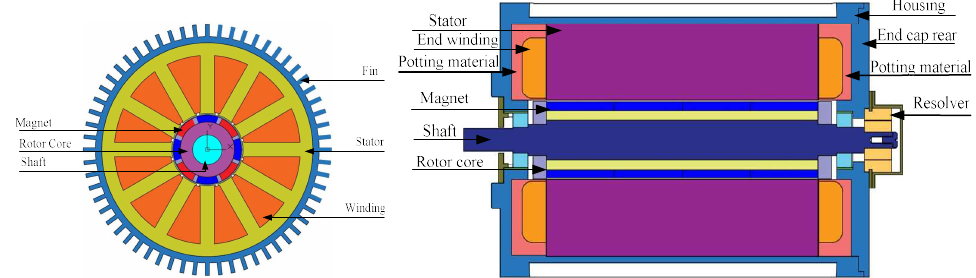
Figure1. The initial motor structure. Figure 1. The initial motor structure.